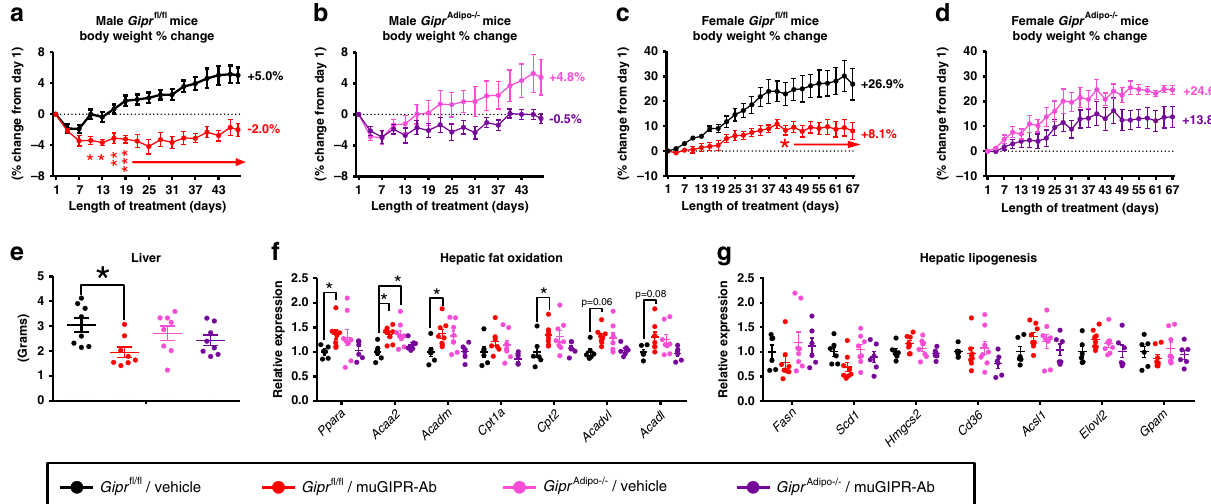
Fig. 6 GIPR activity in adipocytes partially contributes to the effect of muGIPR-Ab to prevent weight gain in DIO mice. Male a Gipr fl / fl and b Gipr Adipo − / − littermates fed HFD for 12 weeks (represented in Fig. 5g – j) were treated with vehicle or muGIPR-Ab (25 mg/kg every 6 days) for 48 days and body weight change measured over time. n = 8 mice/group Gipr fl / fl /Vehicle, Gipr fl / fl /muGIPR-Ab, and Gipr Adipo − / − /Vehicle, and n = 7 mice Gipr Adipo − / − /muGIPR-Ab; two-way repeated measures ANOVA with Sidak ’ s test for multiple comparisons; a day 10 * p = 0.028, day 13 * p = 0.035, day 15 ** p = 0.0082, and days 19 – 48 **** p ≤ 0.0001. Data are presented as mean values ± SEM. Female ( c ) Gipr fl / fl and ( d ) Gipr Adipo − / − littermates fed HFD for 8 weeks were treated with vehicle or muGIPR-Ab (25 mg/kg every 6 days) for 67 days and body weight change measured over time. n = 5 mice/group Gipr fl / fl /Vehicle, Gipr fl / fl / muGIPR-Ab, and Gipr Adipo − / − /muGIPR-Ab, and n = 4 mice Gipr Adipo − / − /Vehicle; two-way repeated measures ANOVA with Sidak ’ s test for multiple comparisons; c day 43 * p = 0.027, day 46 * p = 0.018, days 49-48 ** p ≤ 0.0050, days 61 – 67 *** p ≤ 0.008. Data are presented as mean values ± SEM. e Liver weight from male Gipr fl / fl and Gipr Adipo − / − treated with vehicle or muGIPR-Ab for 48 days were collected at necropsy, one-way ANOVA with Sidak ’ s test for multiple comparisons, * p = 0.024. Hepatic f fat oxidation and g lipogenesis genes were measured by Quantigene Plex. n = 8 mice/group Gipr fl / fl /Vehicle, Gipr fl / fl /muGIPR-Ab, and Gipr Adipo − / − /Vehicle, and n = 7 mice Gipr Adipo − / − /muGIPR-Ab; two-way ANOVA with Sidak ’ s test for multiple comparisons; Ppara * p = 0.033, Acaa2 * p = 0.032, Acadm * p = 0.025, and Cpt2 * p = 0.042. Data are presented as mean values ±